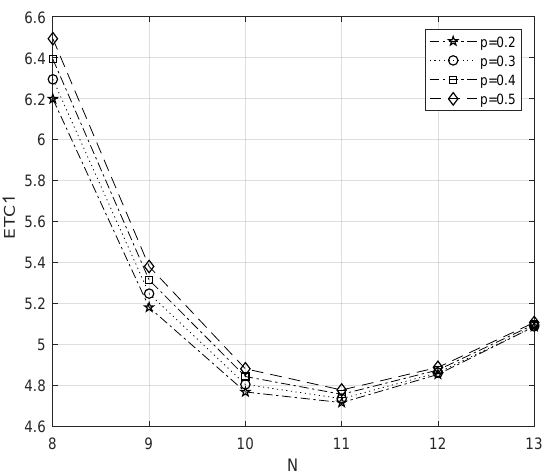
Figure 9. The impact of ETC when N vs p for